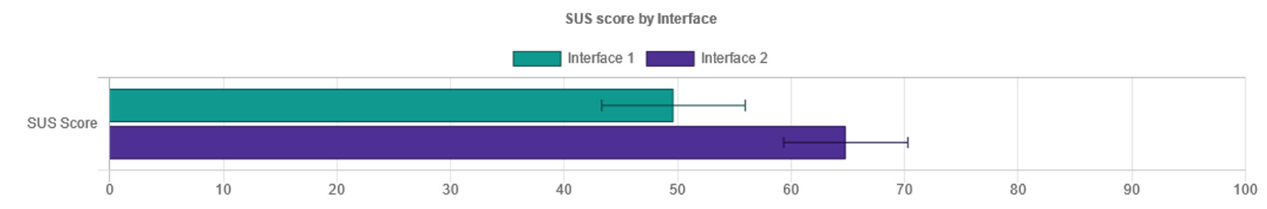
Figure 9. SUS score by interface.